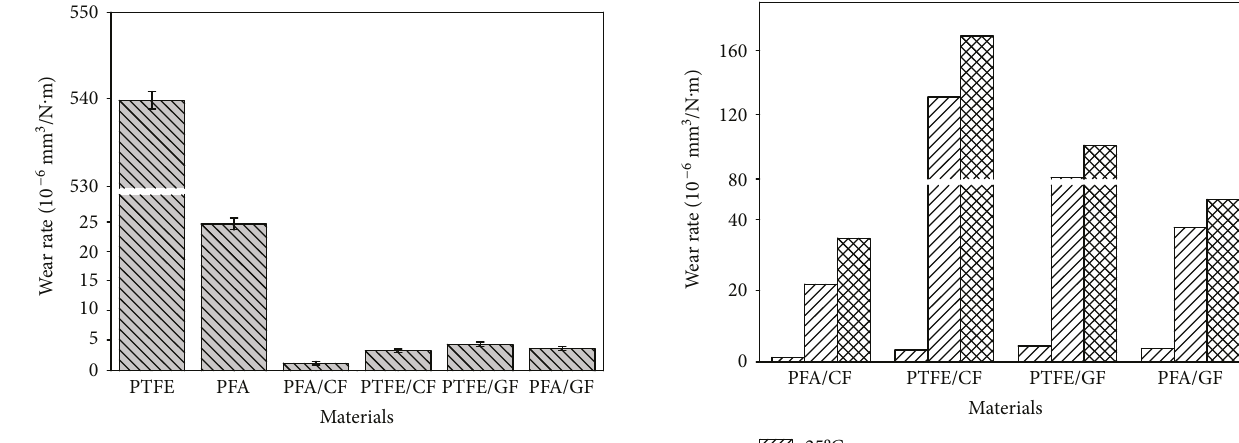
Figure 3: Wear rates of the PTFE and PFA composites.